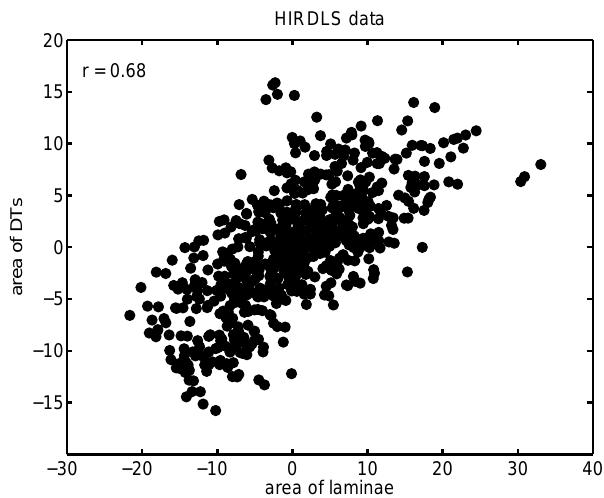
Fig. 5. Correlation between the area covered with DTs and the area covered with ozone laminae in the latitude band 22–72 ◦ N as ob- Fig.5. CorrelationbetweentheareacoveredwithDTsandtheareacoveredwithozonelaminaeinthelatitude served by the HIRDLS satellite instruments. Only November to band 22 ◦ –72 ◦ N as observed by the HIRDLS satellite instruments. Only November to June anomalies are plotted. Thecorrelationisstatisticallysignificantatthe99%level(seetext). June anomalies are plotted. The correlation is statistically signifi- cant at the 99% level (see